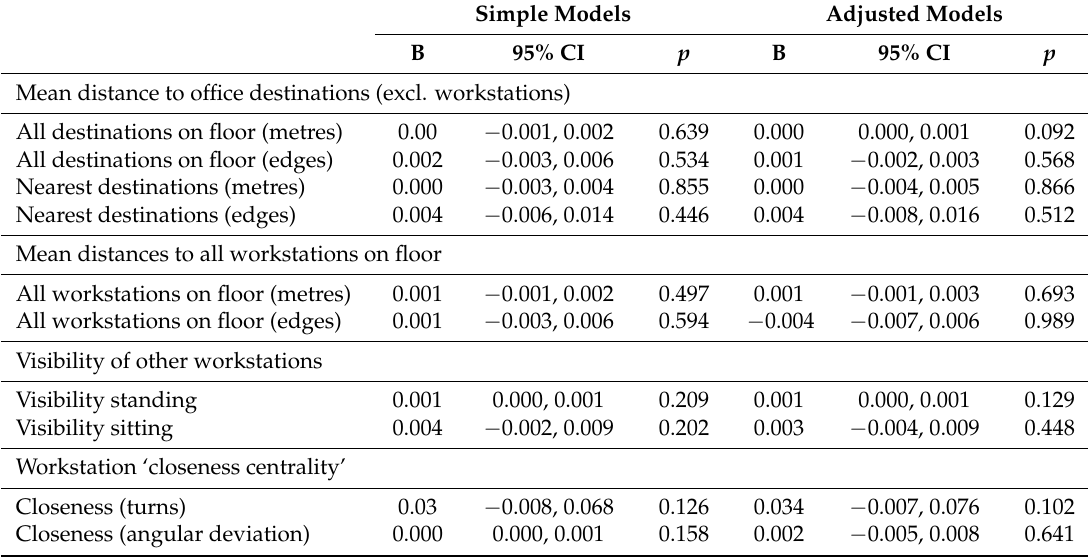
Table 4. Associations between spatial variables and minutes of workplace sitting time per hour. Simple